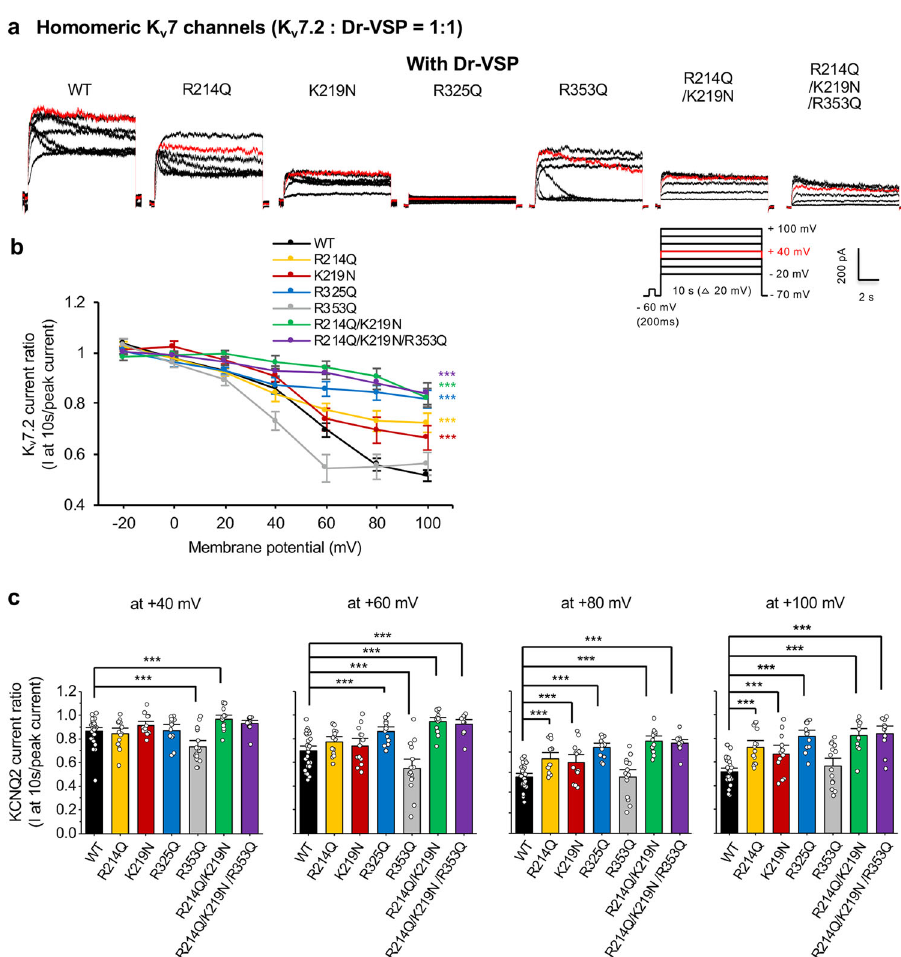
Fig. 5 Charge-neutralizing mutations of potential PIP 2 binding residues alter K v 7.2 current response to Dr-VSP activation. a Representative current traces showing Dr-VSP-mediated K v 7.2 current decay in CHO hm1 cells co-expressing Dr-VSP and K v 7.2 WT or mutants from − 20 mV to + 100 mV. CHO cells were held at – 70 mV, and a brief voltage step to – 60 mV was applied to calculate the linear leak. 10 s step depolarizations were applied in 20-mV steps from – 20 to + 100 mV with 2 min inter-step intervals to allow PIP 2 regeneration. Red trace shows current decay curve when cells were held at + 40 mV. b Ratio of current decay in K + 40 mV, + 60 mV, + 80 mV and v 7.2 WT or mutant channels at each voltage step. c K v 7.2 current decay ratio at + 100 mV. The number of cotransfected cells that were recorded with EGFP-tagged Dr-VSP: K n = 27), R214Q ( n = 14), K219N ( n = 13), R325Q v 7.2 WT ( ( n = 12), R353Q ( n = 15), R214Q/ K219N ( n = 13) or R214Q/K219N/R353Q ( n = 11). The source data for Fig. 5b is available in Figshare 93 . Data represent the mean ± SEM. One-way ANOVA Fisher ’ s test results are shown (* p < 0.05, ** p < 0.01 and *** p <